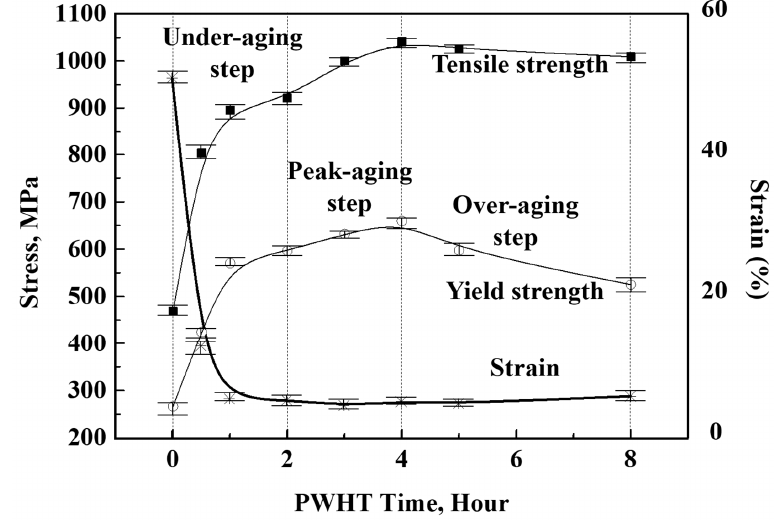
Figure 10. Behavior of the tensile properties of FSW joints after a post-weld heat